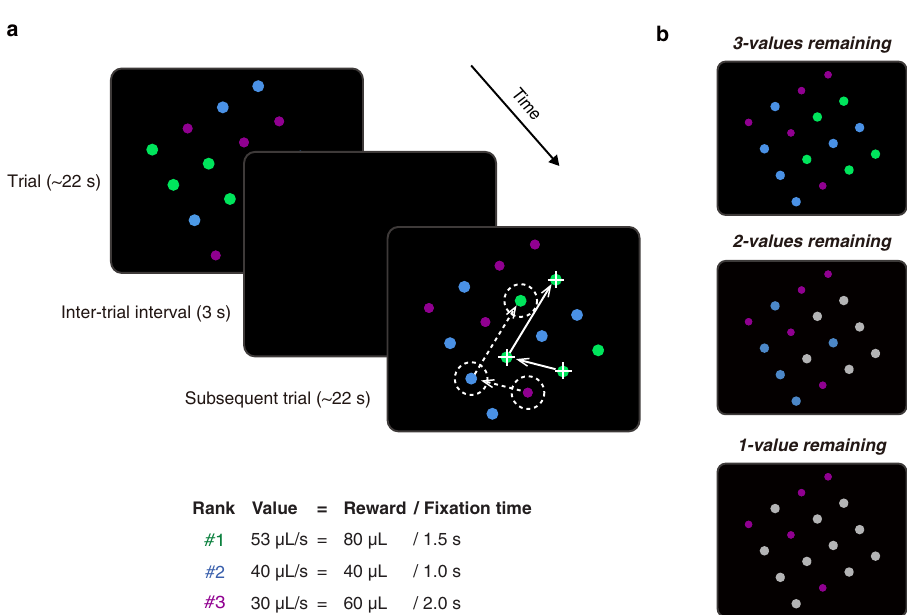
Fig. 1 Saccade foraging task. a Two example trials of the saccade foraging task. The 4 × 4 array was composed of targets of three colors. Each target color was associated with a particular value determined by its water reward magnitude divided by the fi xation time required to harvest this reward. When monkeys fi xated a target for the pre-speci fi ed time, the color would turn into an equiluminant gray and corresponding reward was delivered, cueing the move to the subsequent target. In this example block, the rank of target values descended from green to blue to red. For illustration purposes, purple is used to represent red color in task paradigm. In successive trials, the association between color and value remained constant but the location of the colored targets within the array was randomized. The array size and orientation were tailored such that when the monkey was fi xating a target (white cross), an adjacent target was positioned in the center of the pre-mapped response fi eld (RF) of the isolated SC neuron (white dashed circle). The white arrows illustrate how the fovea and RF move in tandem as monkeys foraged targets in the array (More detail in Supplementary Movie 1). In a small number of experiments, larger response fi eld eccentricities necessitated smaller 3 × 4 or 3 × 3 target arrays to fi t on the visual display. b Examples of different menus. As monkeys tended to harvest targets in descending order of their value, the menu of items went from 3-values remaining (top), to 2-values remaining (middle), and fi nally 1-value remaining